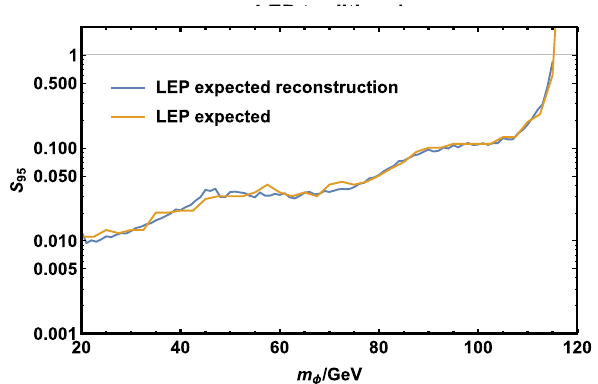
Fig. 1 The expected limit from LEP for the analyses using the φ → b ¯ b decay information is compared with our method for approximately reconstructing the expected limit for S 95 from the process e + e − → Z ( H /φ) → μ + μ − b ¯ b . Our approximate result makes use of the two scaling factors c bb given in Table 2